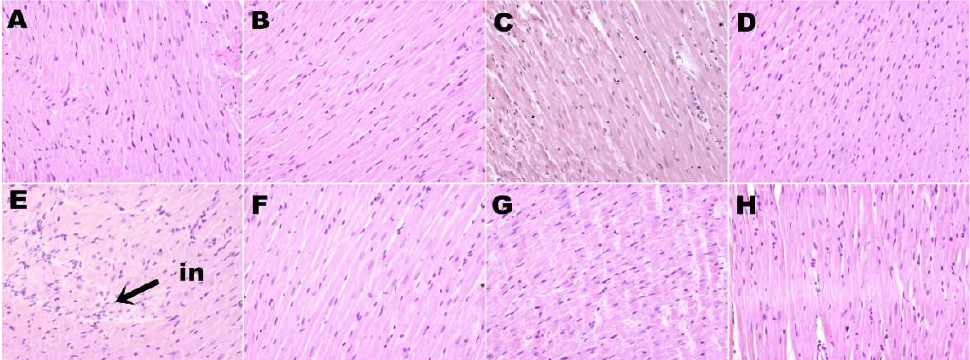
Figure 2. Hematoxylin and eosin staining of left ventricle showing infiltration of inflammatory cells (magnification ×20; shown by arrow) in rats fed corn starch diet-fed rats ( A ), corn starch diet-fed rats treated with whole linseed ( B ), corn starch diet-fed rats treated with defatted linseed ( C ), corn starch diet-fed rats treated with SDG ( D ), high-carbohydrate, high-fat diet-fed rats ( E ), high-carbohydrate, high-fat diet-fed rats treated with whole linseed ( F ), high-carbohydrate, high-fat diet-fed rats treated with defatted linseed ( G ), and high-carbohydrate, high-fat diet-fed rats treated with SDG ( H ). Inflammatory cells are marked as “in”.